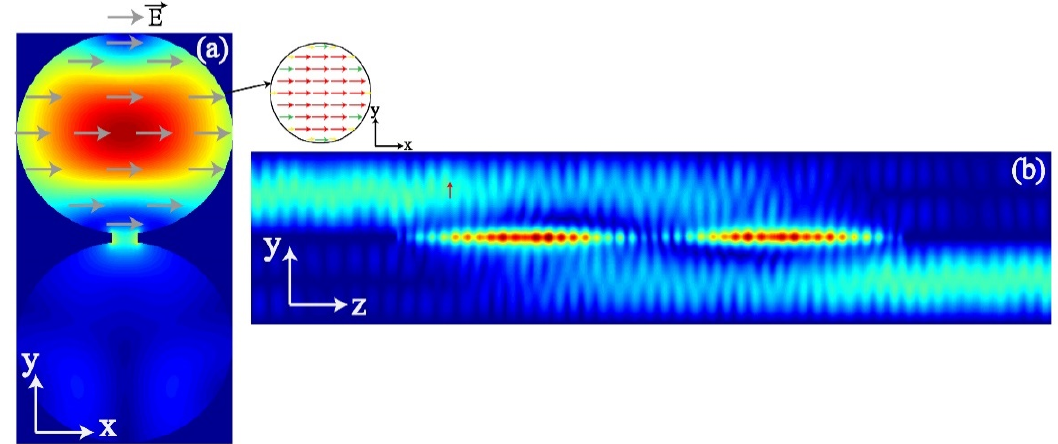
Figure 2. Horizontal polarization wave inputting: ( a ) coupling slot structure direction and the transverse electric field and ( b ) longitudinal electric field (YZ cross section).